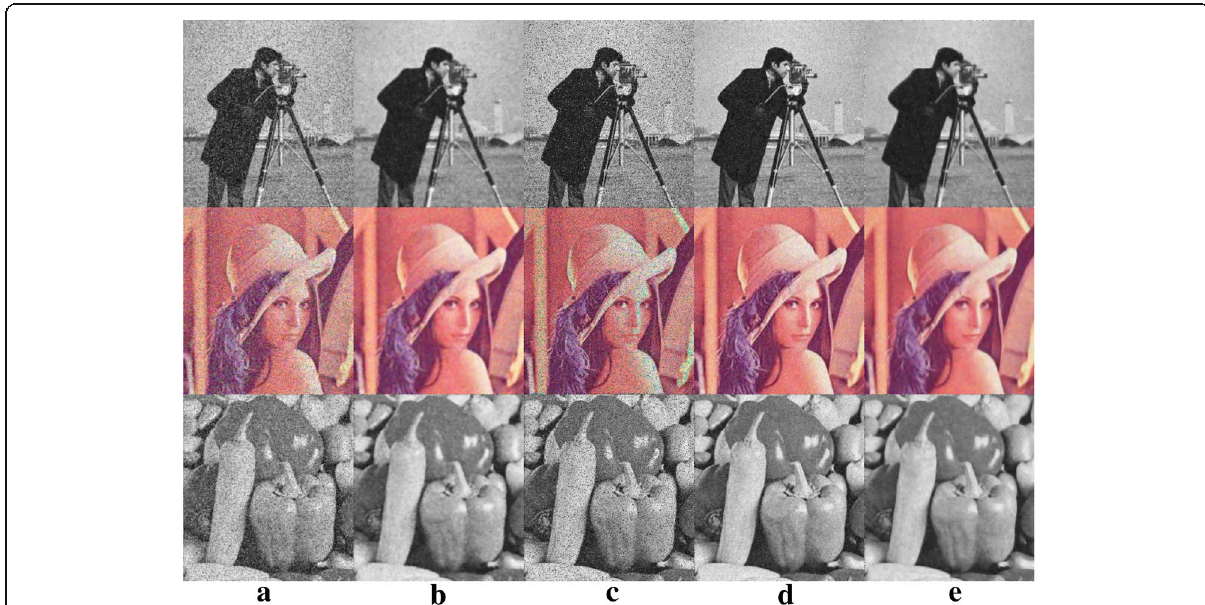
Fig. 4 Performance of a RF ( λ = 0.25), b AMD ( λ = 0.25), c AADF ( λ = 0.25), d FORADF ( λ = 0.25), and e FORADF ( λ = 1) for low density mixed noise. λ represents the control parameter, and n represents the number of iterations. The results are given for low density mixed noise, i.e., Gaussian noise of variance 0.1 plus salt and pepper noise of density